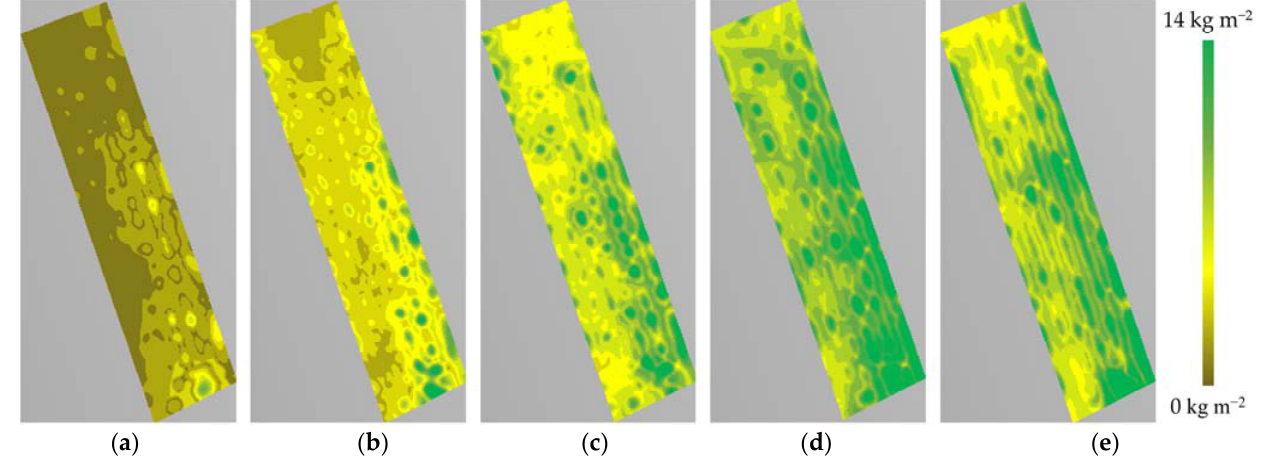
Figure 13. Measured AGB maps from ( a ) 19 December 2019, ( b ) 25 January 2020, ( c ) 4 March 2020, ( d ) 10 April 2020, and ( e ) 12 May 2020.